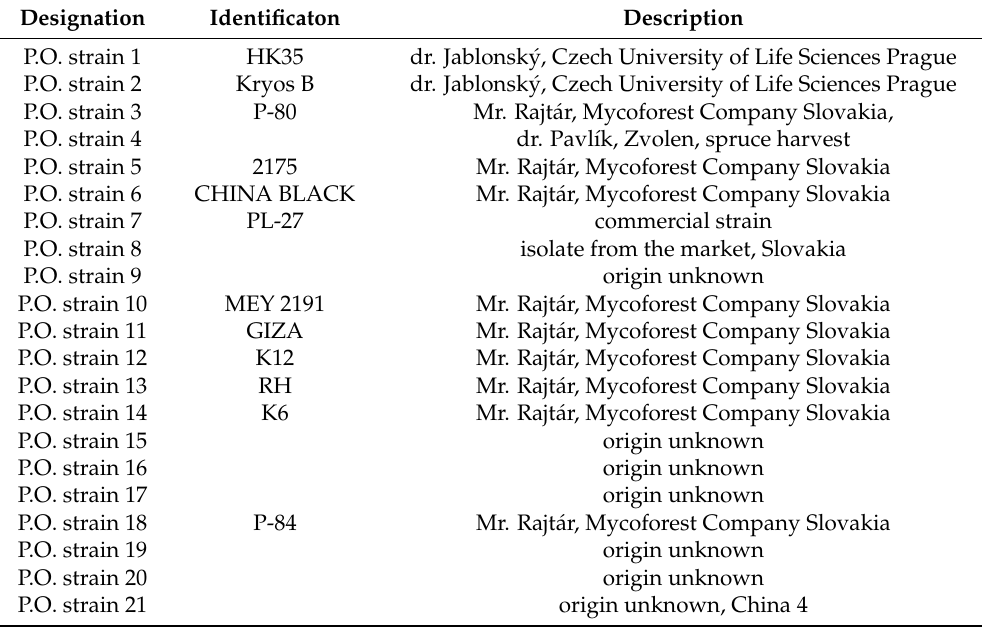
Table 1. Biological material/strains of Pleurotus ostreatus